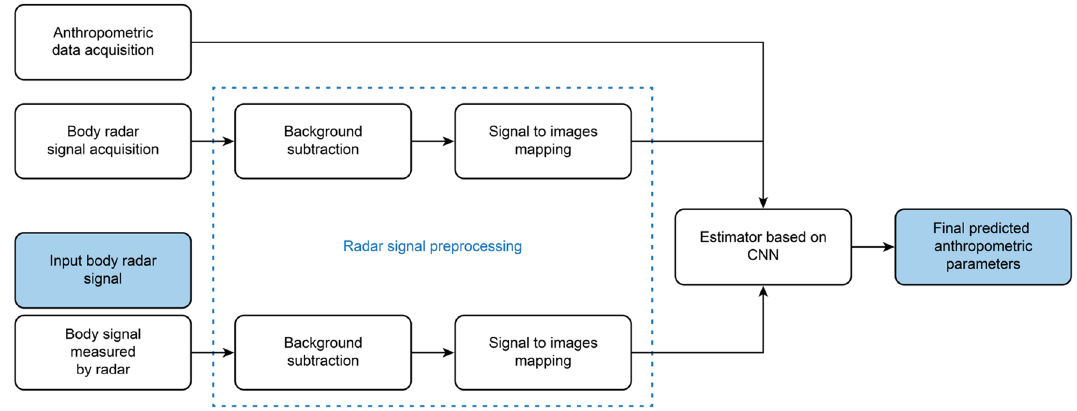
Figure 2. Proposed method for anthropometric parameter estimation using a convolutional neural